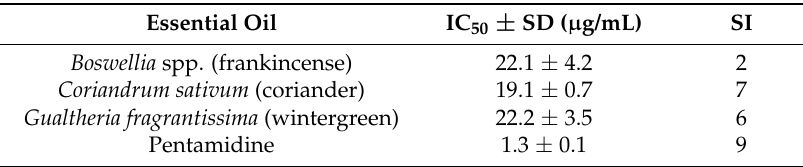
Table 2. Screening of frankincense, coriander, and wintergreen essential oils against Leishmania amazonensis intracellular amastigotes.